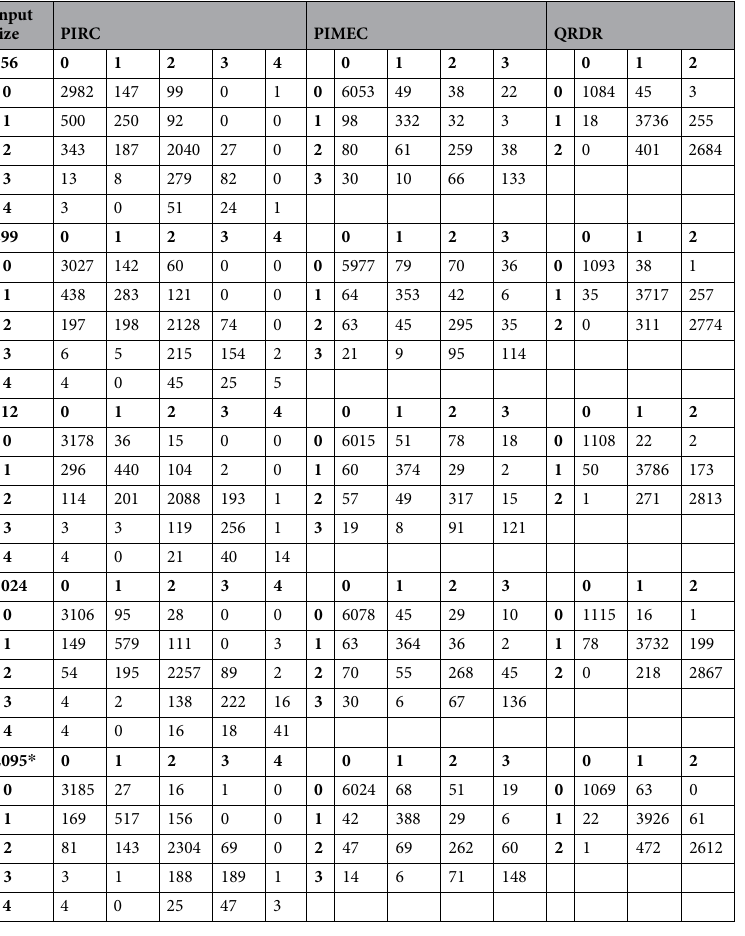
Table 6. Confusion matrices for PIRC, PIMEC and QRDR classification tasks with varying input size on the primary validation set. Ground truth shown in rows and predicted classes in columns. PIRC classes (0 = no apparent DR, 1 = mild NPDR, 2 = moderate NPDR, 3 = severe NPDR, 4 = PDR), PIMEC classes (0 = no apparent DME, 1 = mild DME, 2 = moderate DME, 3 = severe DME) and QRDR classes (0 = ungradable, 1 = NRDR, 2 = RDR). * Model trained using instance normalization layers, instead of batch normalization, and optimizer updates accumulated over 15